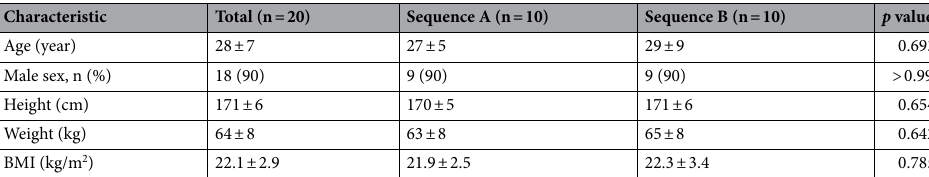
Table 1. Baseline characteristics. A total of 20 healthy subjects were randomly assigned to sequence A (ivabradine first, placebo second) or sequence B (placebo first, ivabradine second). Data are expressed as means ± standard deviation unless otherwise indicated. There were no significant differences in baseline characteristics between the sequences. BMI body mass index.